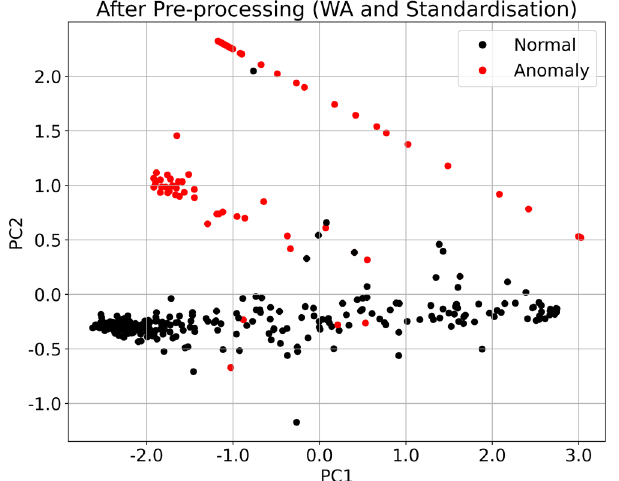
Figure 12. The first two principal component plots after